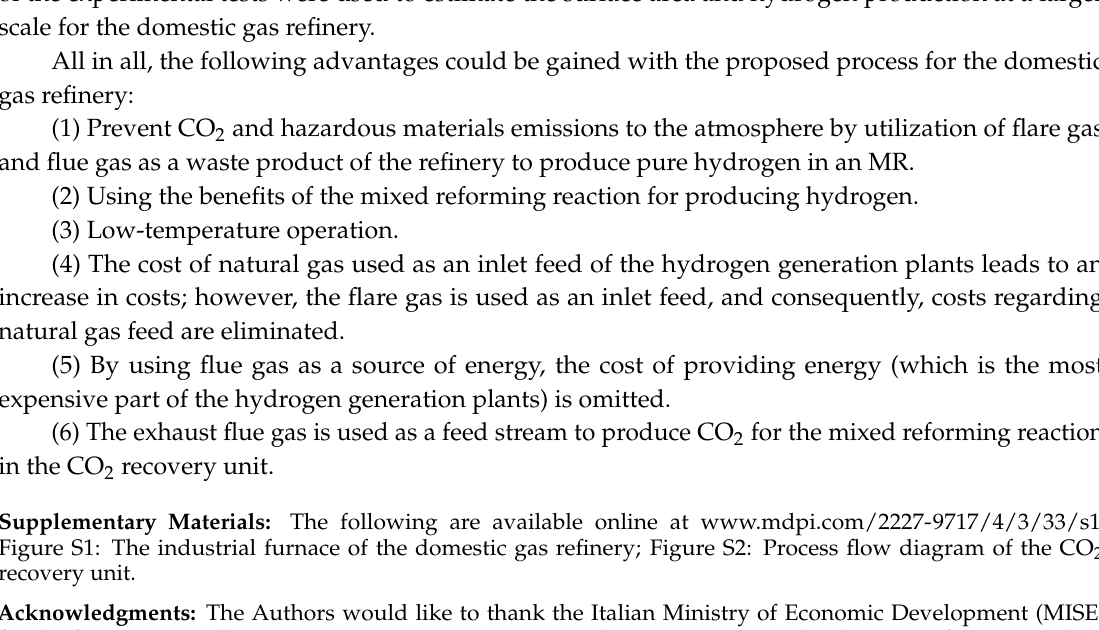
Figure S1: The industrial furnace of the domestic gas refinery; Figure S2: Process flow diagram of the CO 2 recovery